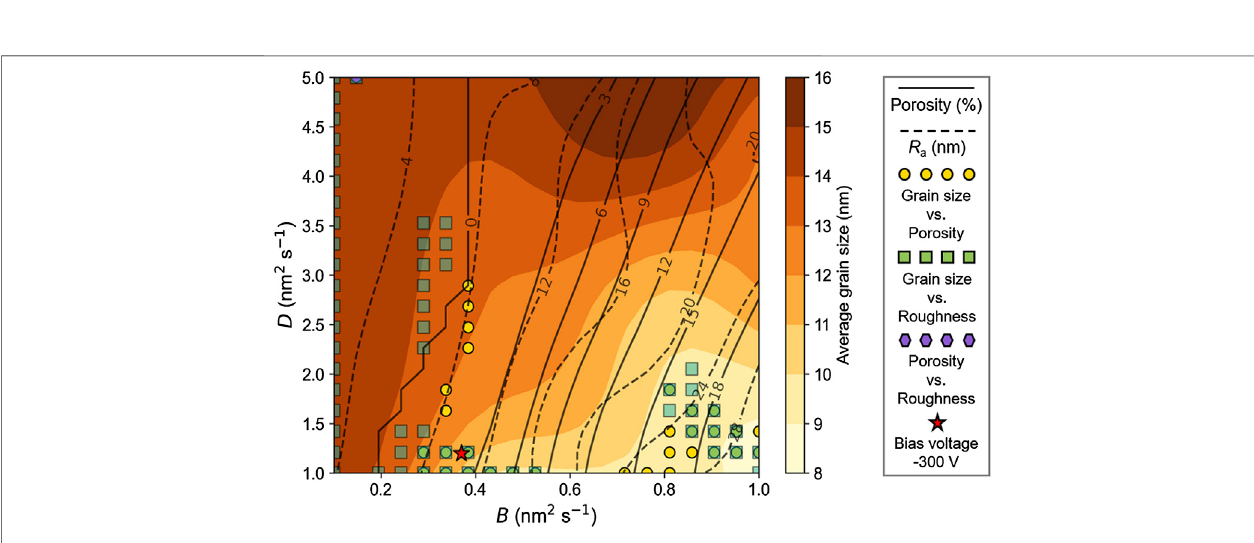
Frontiers in Materials |